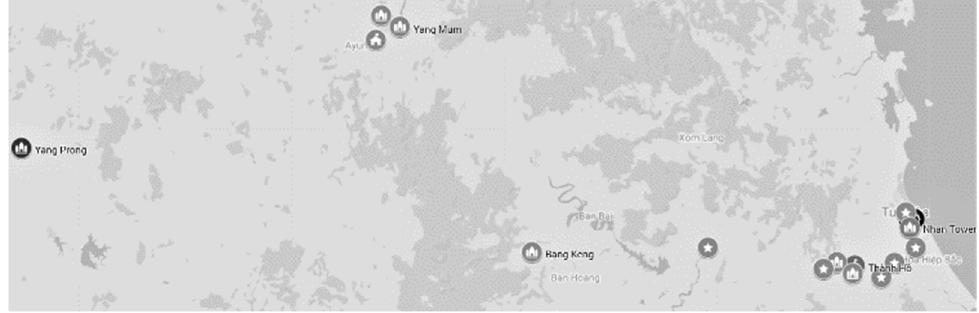
Figure 5. Approximate distribution of Champ ā sites in Phú Yên, Gia Lai, and Đắ k L ắ k provinces (Designed in Google Maps by Noseworthy).